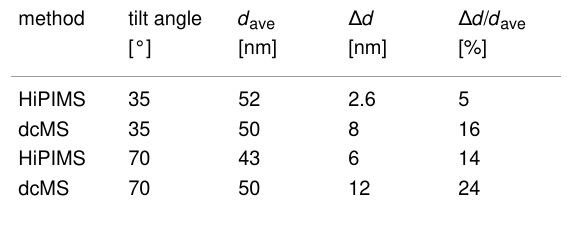
Table 1: Thickness uniformity of the nickel films deposited under various tilt angles and deposition methods. d ave is the average film thickness measured by XRR. Δ d is the thickness difference across the deposited film along the direction of the tilt